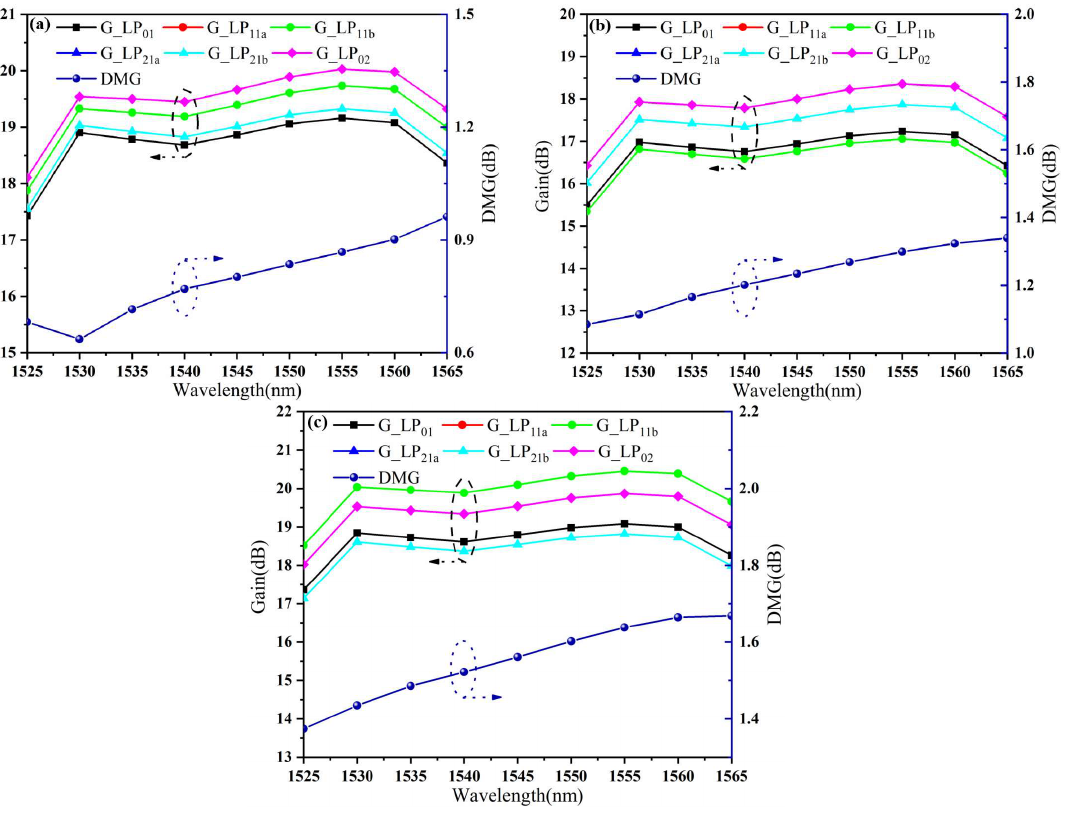
Figure 8. Modal gains and DMGs of ( a ) ideal fiber, ( b ) FM-EDF-LAER, and ( c ) FM-EDF-HAER as functions of the wavelength. Table 1. Influence of fiber residual stress on the MGE of FMFAs.